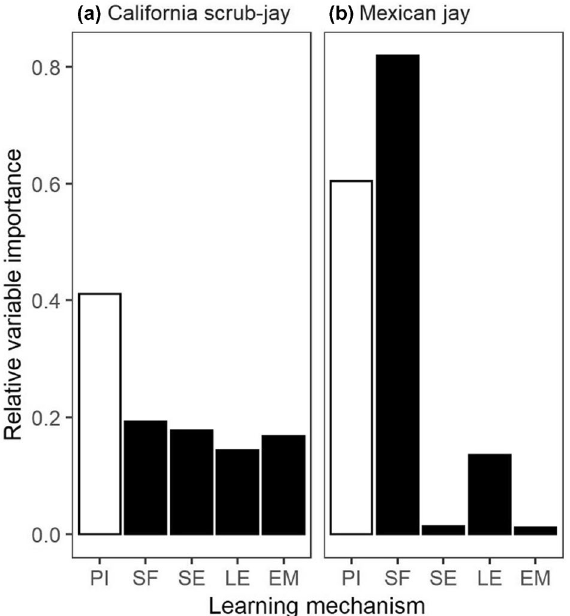
Figure 2. The relative importance of the variables representing personal information (in white; PI) and four social learning mechanisms (in black; social facilitation [SF], stimulus enhancement [SE], local enhancement [LE] and emulation [EM]) on the rate of first interaction with novel doors on the foraging task for each species. Values were calculated by summing the AIC weights from the top 3 models in which each variable occurred (Table 2).